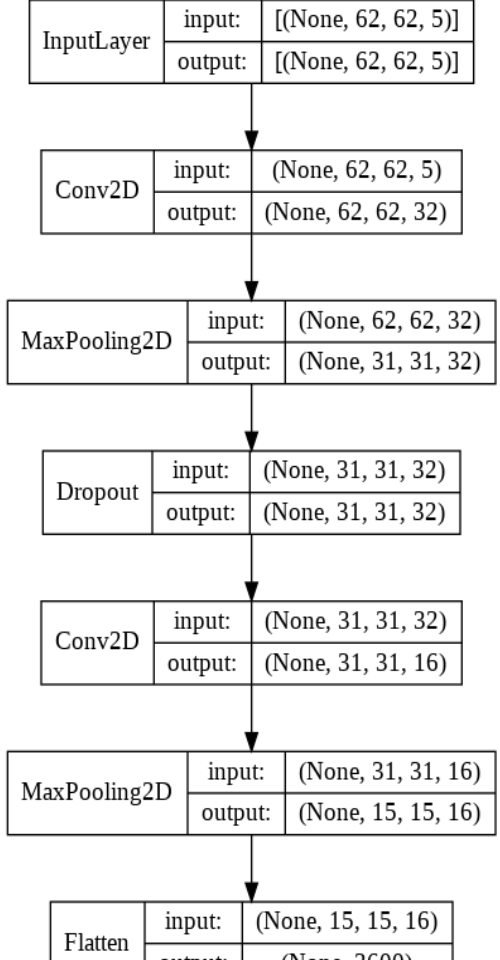
Figure 3. Different layers in the CNN